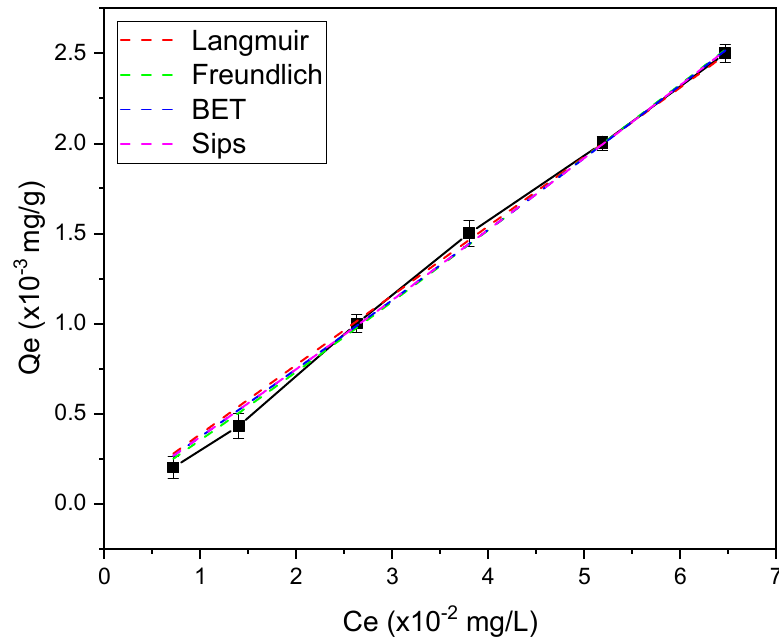
Figure 8. Non-linear fitting of Langmuir, Freundlich, BET, and Sips adsorption isotherm models. The solid line represents the experimental data and dashed lines represent theoretical data. Table 1. Determined isothermal parameters obtained from various models.